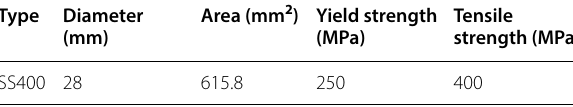
Table 4 Material properties of steel